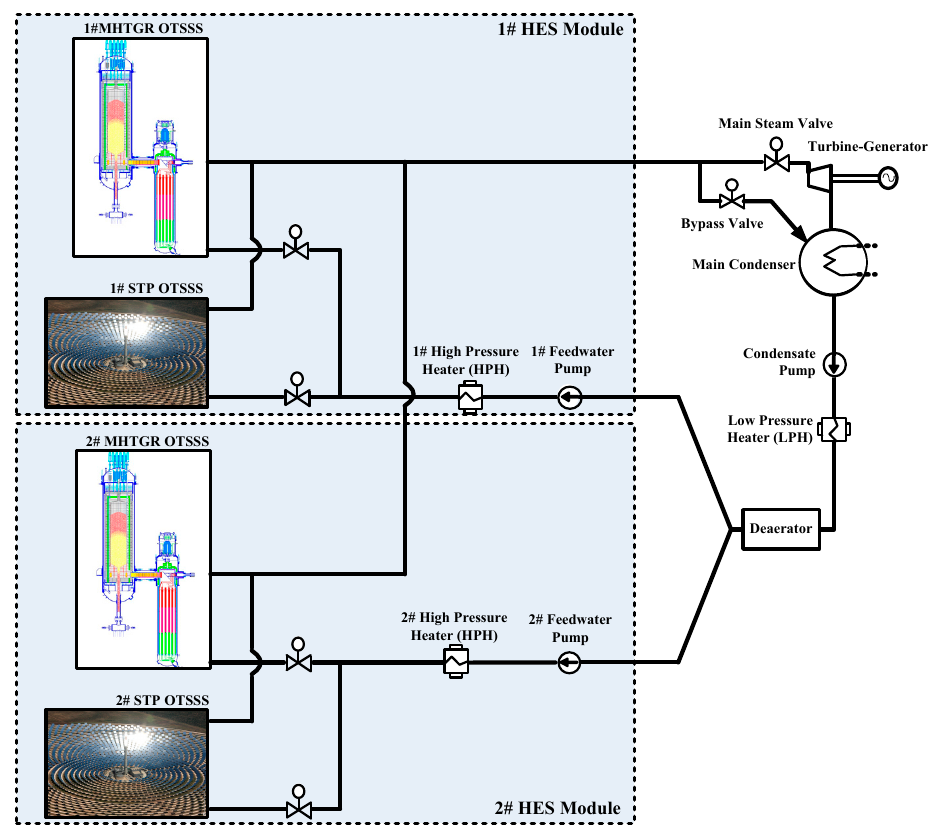
Figure 8. Schematic diagram of a nuclear-solar multimodular hybrid energy system (HES). Table 1. Main design parameters of the nuclear-solar hybrid energy system (HES) at rated